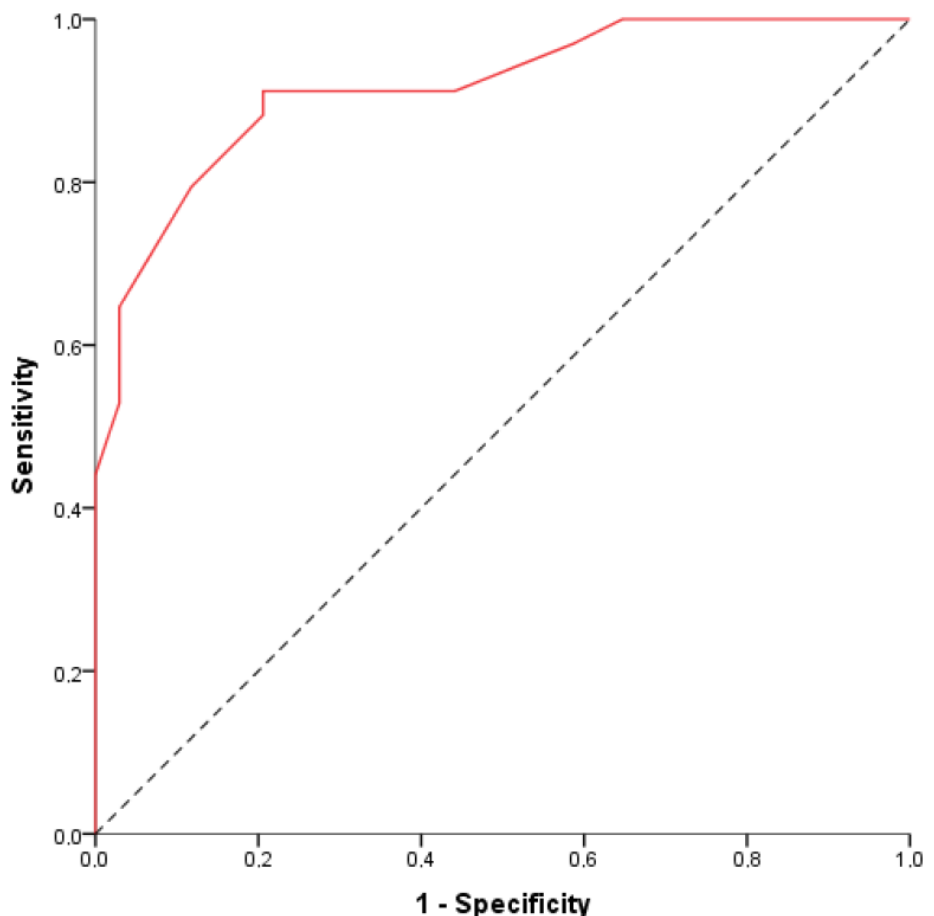
Figure 6. Graph shows area under the curve (AUC) for the final model using the following equation: (1.9 × Well-defined margins) + (1.8 × Maximal enhancement during arterial phase) + (Two Vessel involvement) + (2.4 × No Wirsung duct dilatation) − 4. The final score is obtained using 1 for present and 0 for absent. The area AUC is 0.916 (95% CI: 0.850–0.981).